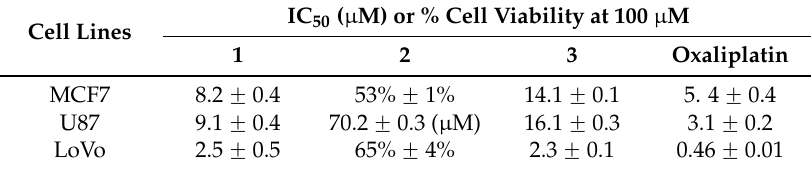
Table 3. Concentration inducing 50% cell survival inhibition (IC 50 ) (except in two cases where is given the % of cell viability at the maximum concentration of 100 µ M) after 72 h